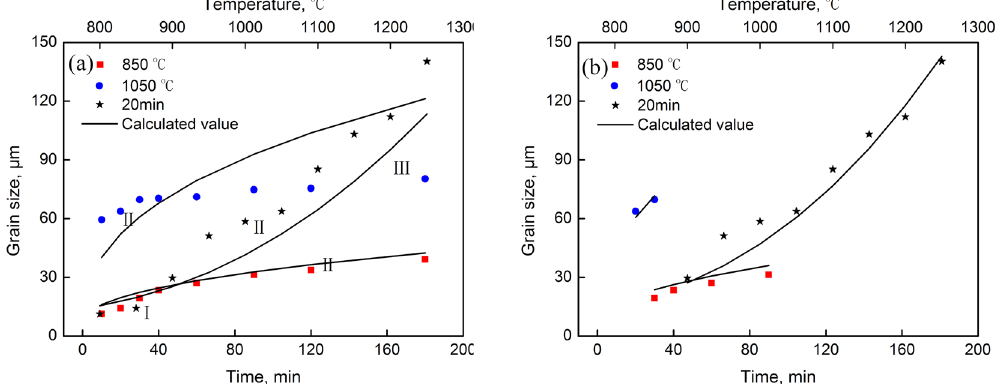
Figure 6. Comparison of the average grain sizes between the measured values and calculated values of the Sellars model. ( a ) Regression analysis of all data; ( b ) Regression analysis of the data from stage